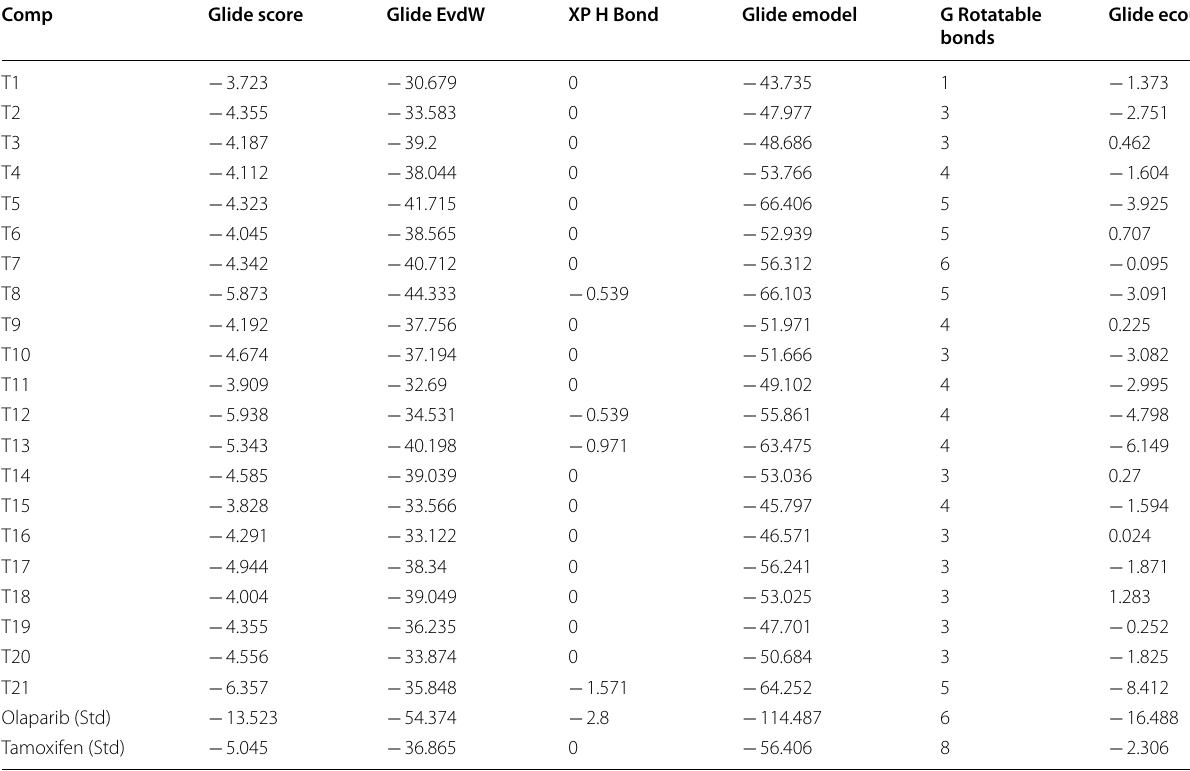
Table 1 Docking studies for compounds (T1-21) with PARP-1 (5DS3)